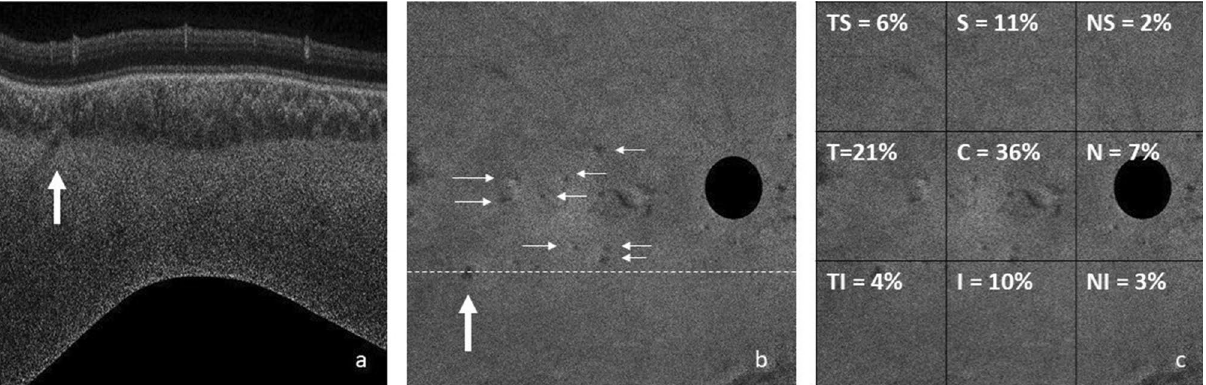
Figure 1. ( a ) Cross sectional B scan flattened around the COI that shows entry of short posterior ciliary artery (SPCA) (arrow) (1:1 pixel); ( b ) En-face scan obtained at the chorio-scleral junction showing entry sites of SPCAs. Dark-black area is the optic nerve location (1:1 pixel); ( c ) distribution of SPCAs over the posterior pole. Most common location is the center square (each square = 4 × 4 mm 2 ) with a 36% entry site. Second most common is central temporal square (21%) (1:1 pixel).